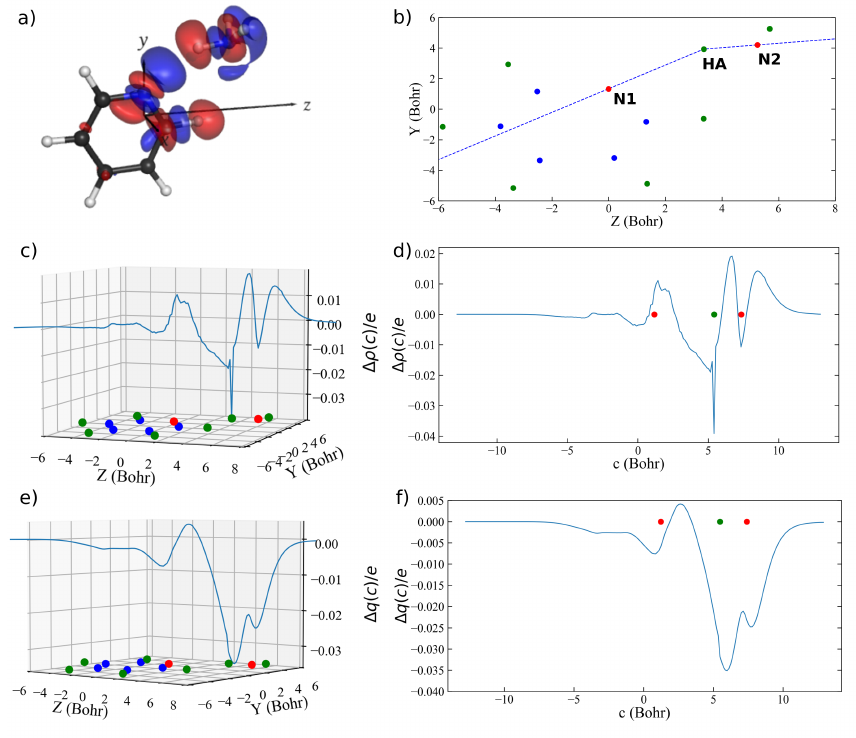
Figure 2. ( a ) ∆ ρ ( x , y , z ) for the pyridine–ammonia complex (isodensity surfaces at ± 0.0005 e/bohr 3 ; red lobes: electron depletion; blue lobes: electron accumulation). ( b ) Curvilinear path c lying in the pyridine molecular plane. ( c ) ∆ ρ ( z ) represented on the pyridine molecular plane. ( d ) ∆ ρ ( z ) linearized as a function of the curvilinear coordinate c . ( e ) ∆ q ( z ) represented on the pyridine molecular plane. ( f ) ∆ q ( z ) linearized as a function of the curvilinear coordinate c . The position of the hydrogen, carbon, and nitrogen atoms are indicated with green, blue, and red dots on the molecular plane,